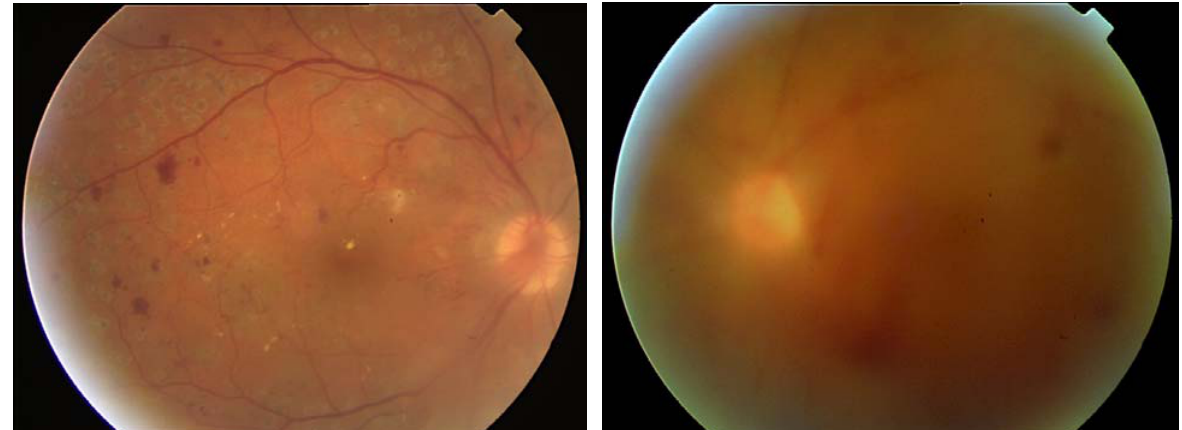
FIGURE 1 . The scars produced by the impact of laser photocoagulation appear as grey retinal round marks surrounding the temporal vascular arcades. Multiple dot and blot hemorrhages and microaneurysms can be seen in the posterior pole. There are two types of white abnormalities: multiple lipid exudate deposition near the macula and a couple of cotton-wool spots temporal to the optic disk. An abnormal tissue emerges from the optic nerve head as well as new vessels, which cannot be properly seen because of hemovitreous.